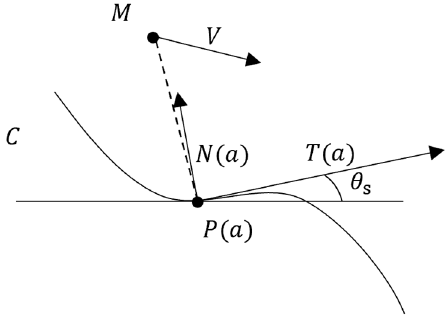
Figure 3. Moving target frame and notation.